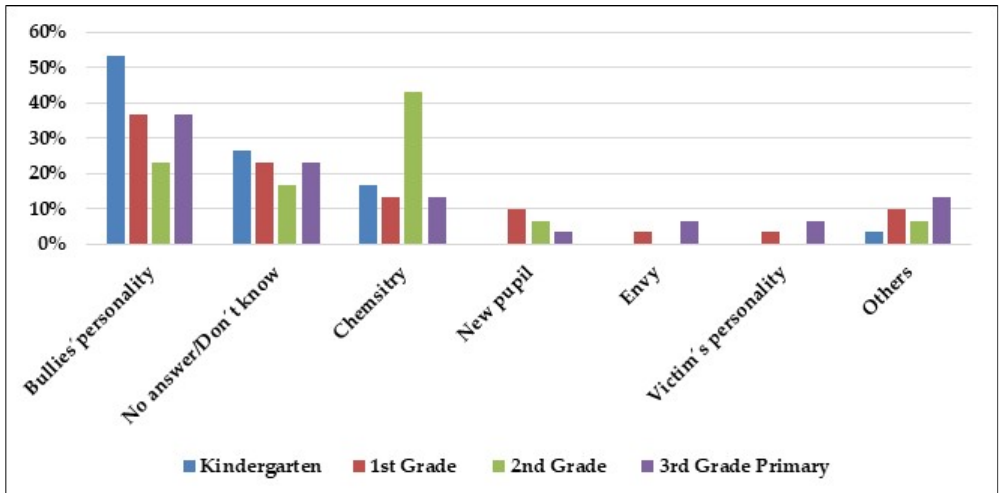
Figure 3. Reasons given per grade.